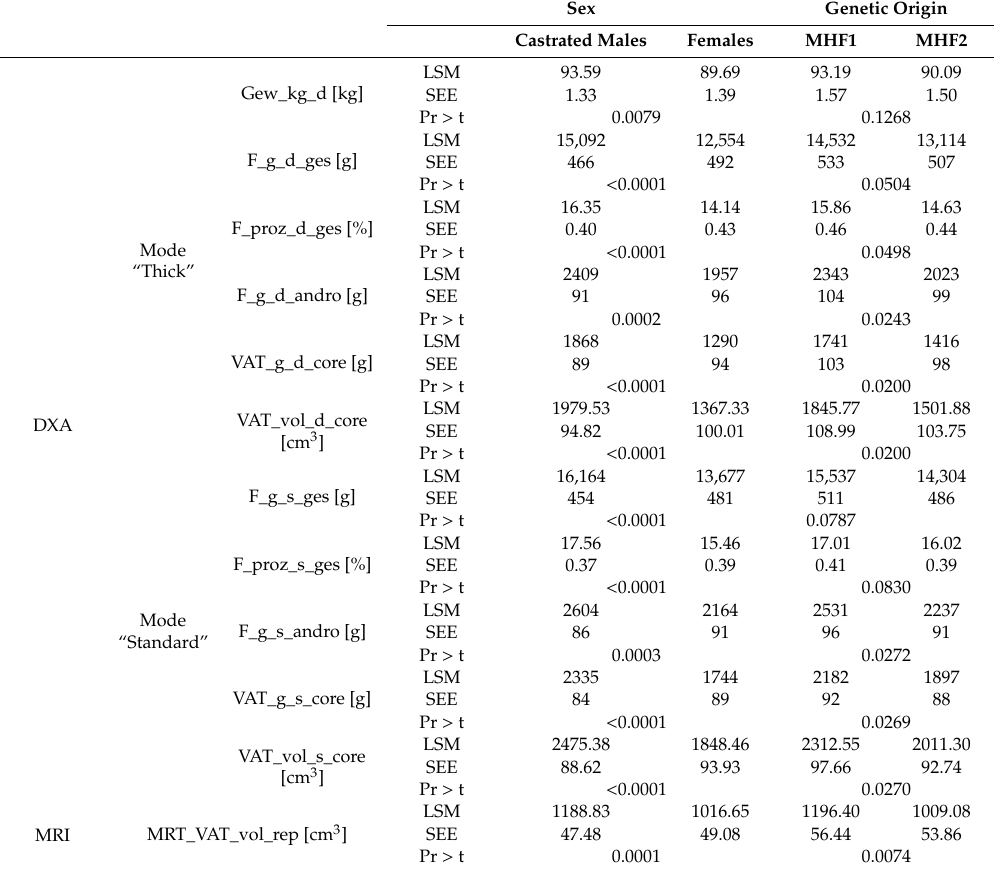
Table 6. Least squares means (LSM), standard errors of estimation (SEE), and significance levels of examined